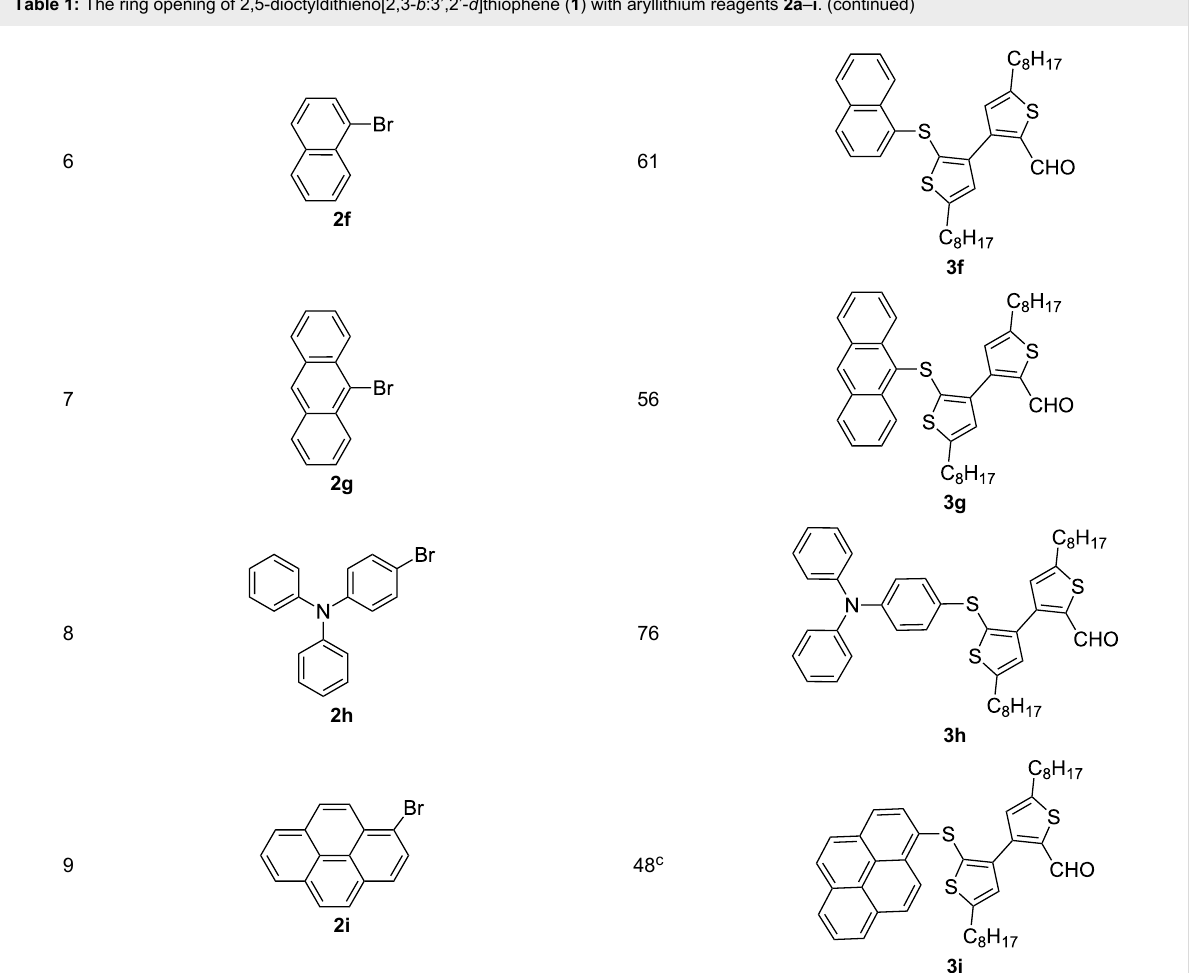
Table 1: The ring opening of 2,5-dioctyldithieno[2,3- b :3’,2’- d ]thiophene ( 1 ) with aryllithium reagents 2a – i . (continued)